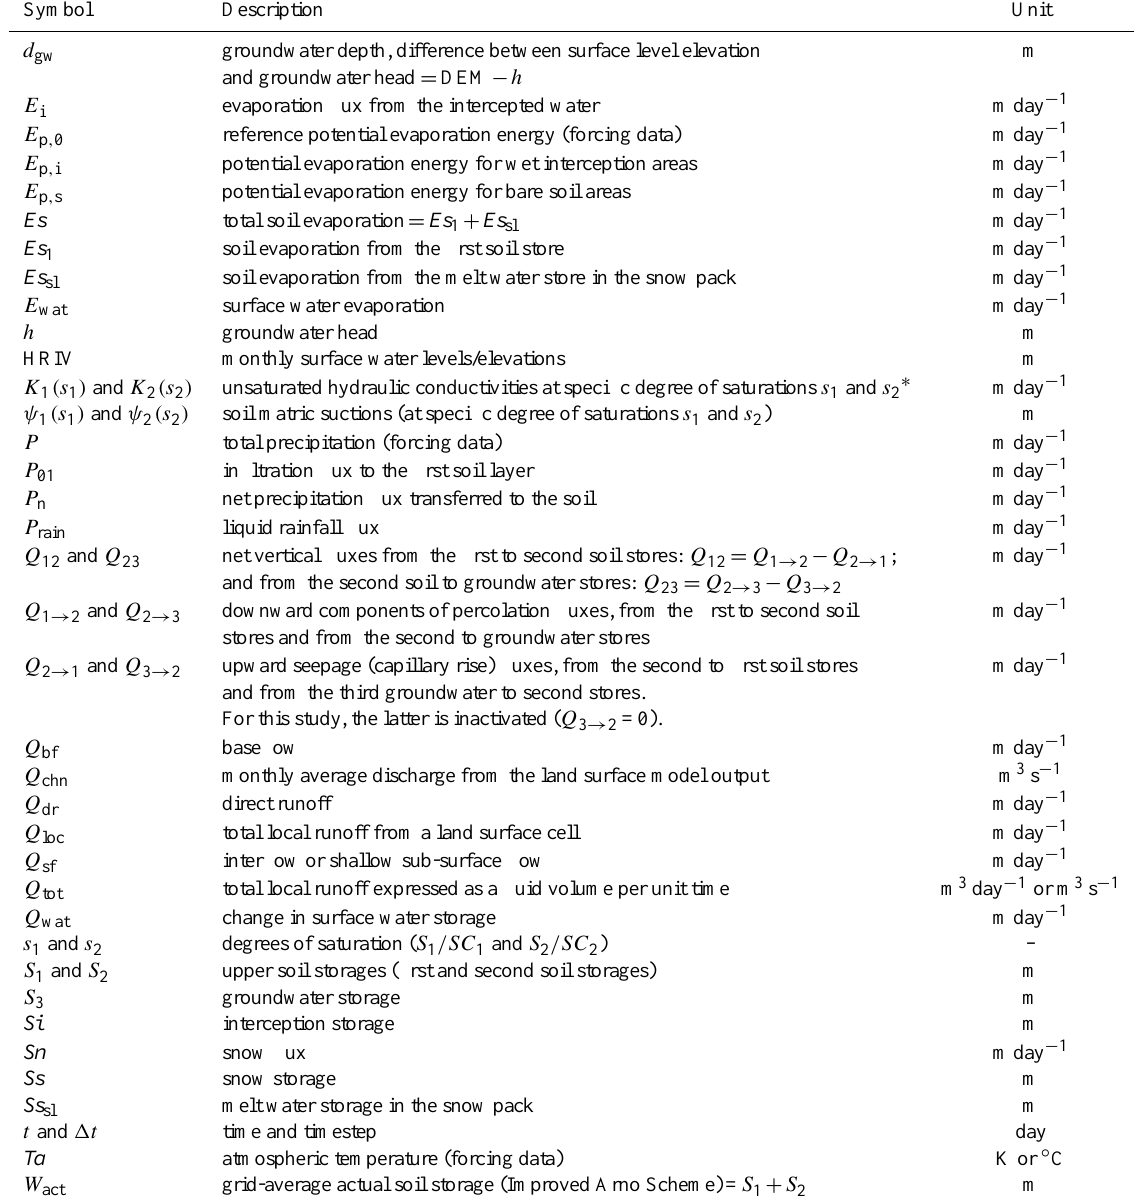
Table 2. List of state and flux variables defined in the model.